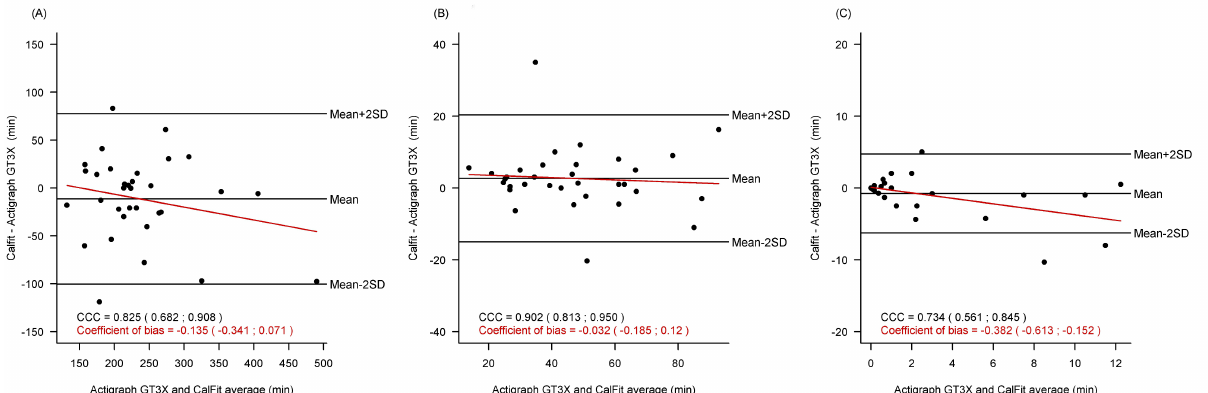
Figure 5. Agreement between CalFit and Actigraph GT3X during light, moderate, and vigorous physical activity within the coinciding days with at least 10 hours of recorded activity. (A) duration of light physical activity per day, (B) duration of moderate physical activity per day, and (C) duration of vigorous physical activity per